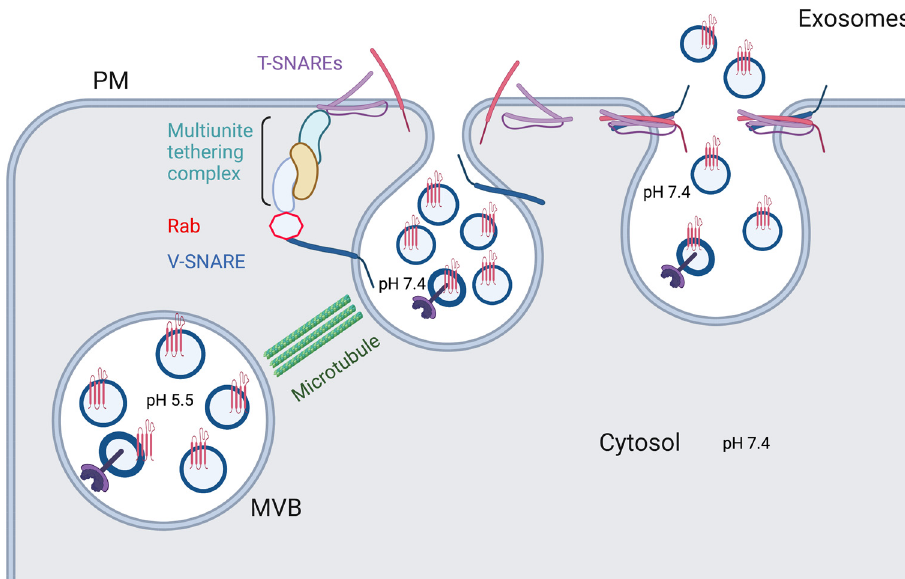
Figure 4. Exosome secretion. With the help of microtubules, Rabs, and tethering factors, one vesicle SNARE (V-SNARE) forms four-helix bundles with two target SNAREs (T-SNARE) to drive the fusion between MVB with plasma membranes to secret exosomes. Created with BioRender.com.